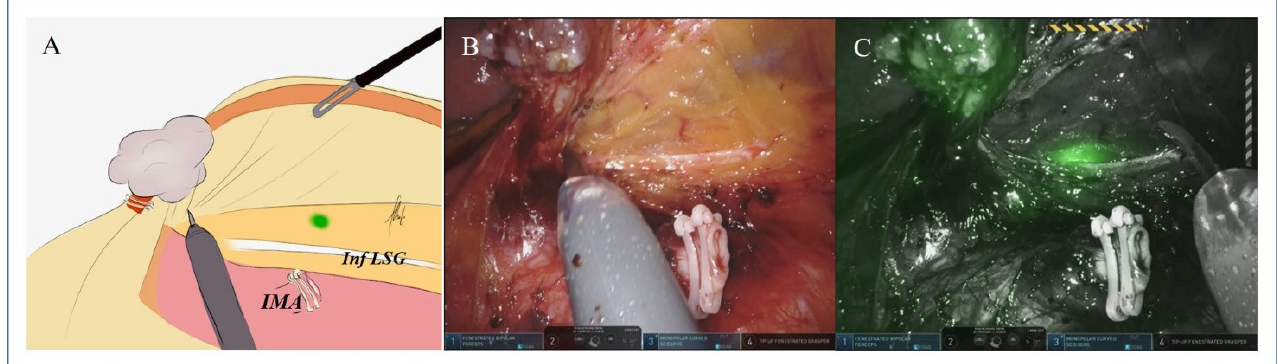
Figure 1. Sketch of the operative field ( A ) and corresponding intraoperative pictures under white ( B ) and NIR ( C ) light of a male patient (#GLTr 69) undergoing robotic left colectomy for a sigmoid cancer. With NIR light, a fluorescent node is visualized on the left side of the aorta below the Gerota’s fascia. Enlarged lymph nodes at the origin of the IMA were harvested and left attached to the distal IMA stump (IMA: inferior mesenteric artery; Inf LSG: inferior branch of the left spermatic ganglion).